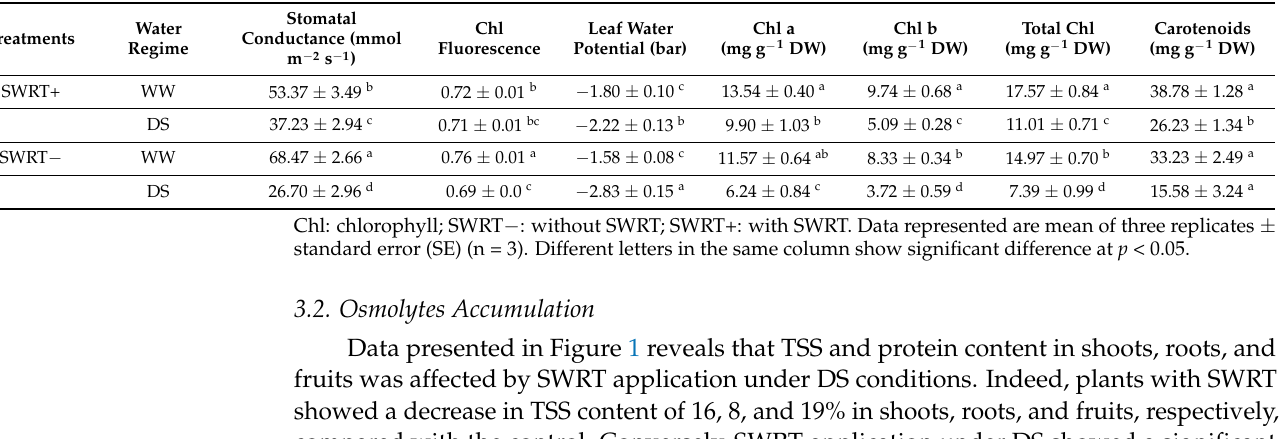
Table 2. Effect of subsurface water retention technology (SWRT) on stomatal conductance, photosyn- thetic efficiency, leaf water potential, chlorophyll, and carotenoid content of tomatoes subjected to different water regimes (DS: drought stress or WW; well-watered) after 4months of cultivation.